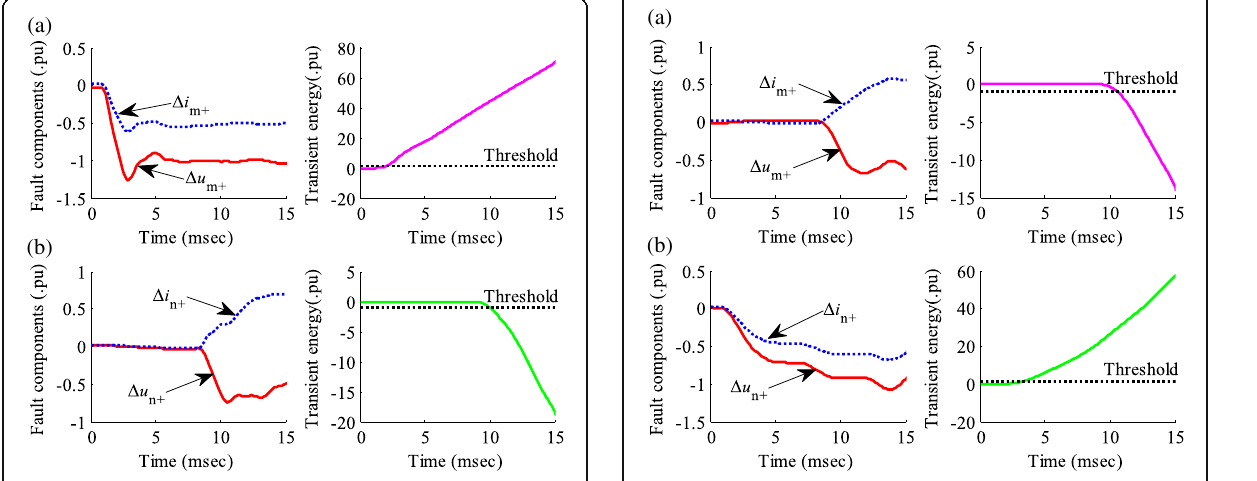
Fig. 12 Waveforms of fault components and transient energies detected on the positive pole line for a fault at F 4. a Rectifier station.